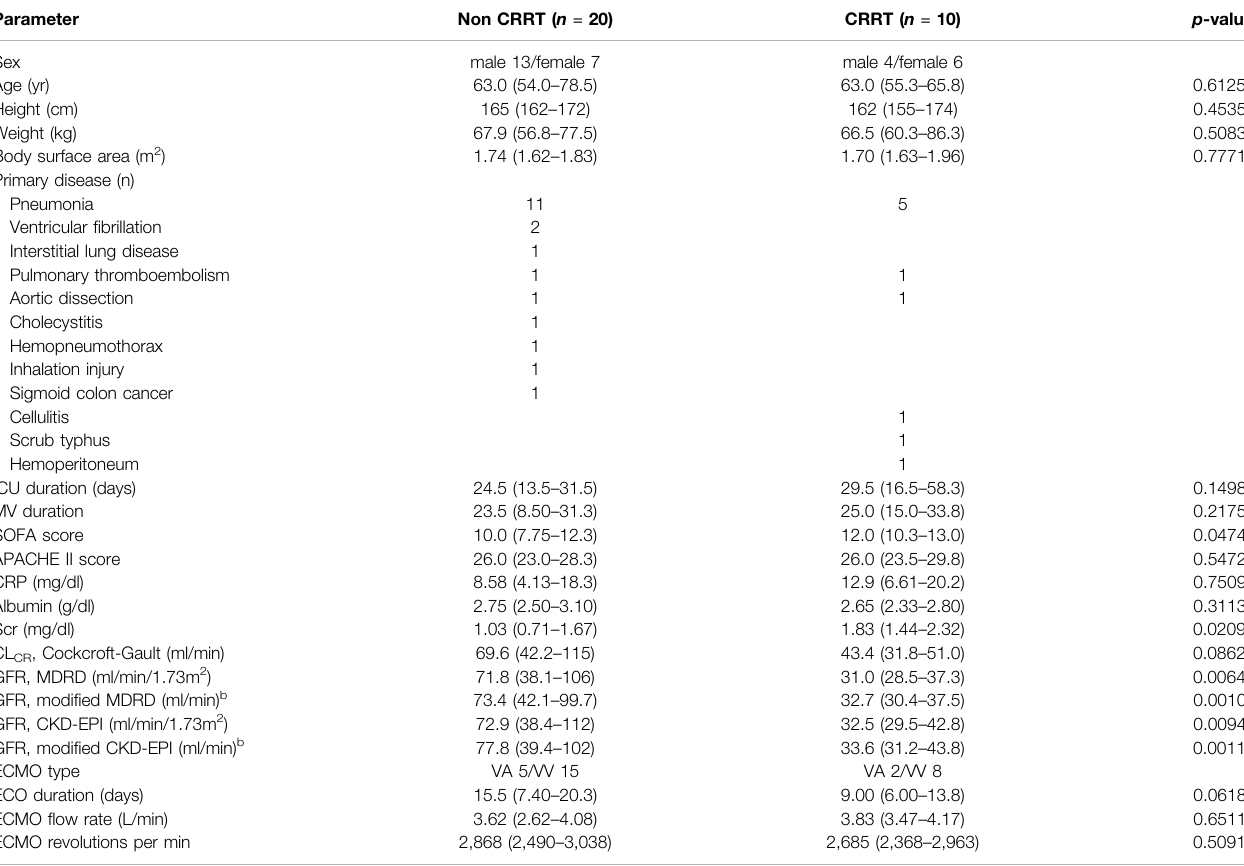
TABLE 1 | Patient characteristics (median(IQR)) a